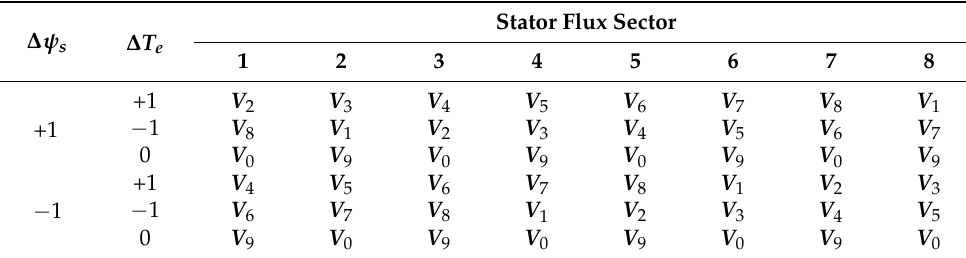
Figure 7. Proposed post-fault direct torque control (DTC) controller. Table 3. Post-fault operation look-up